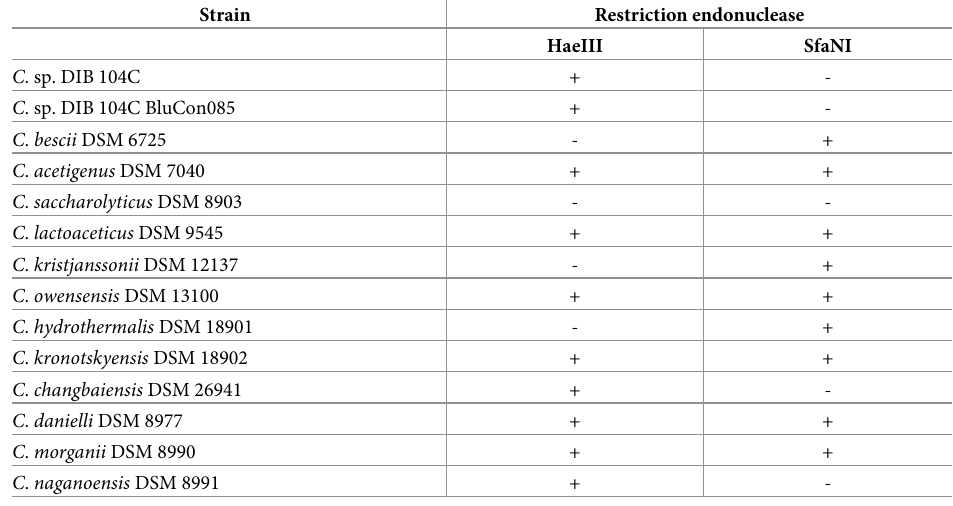
The “+” sign indicates that the genomic DNA is digested by the restriction endonuclease; the “-”sign indicates that the genomic DNA is not digested. Pictures of the corresponding agarose gels are shown in the supporting information (S3